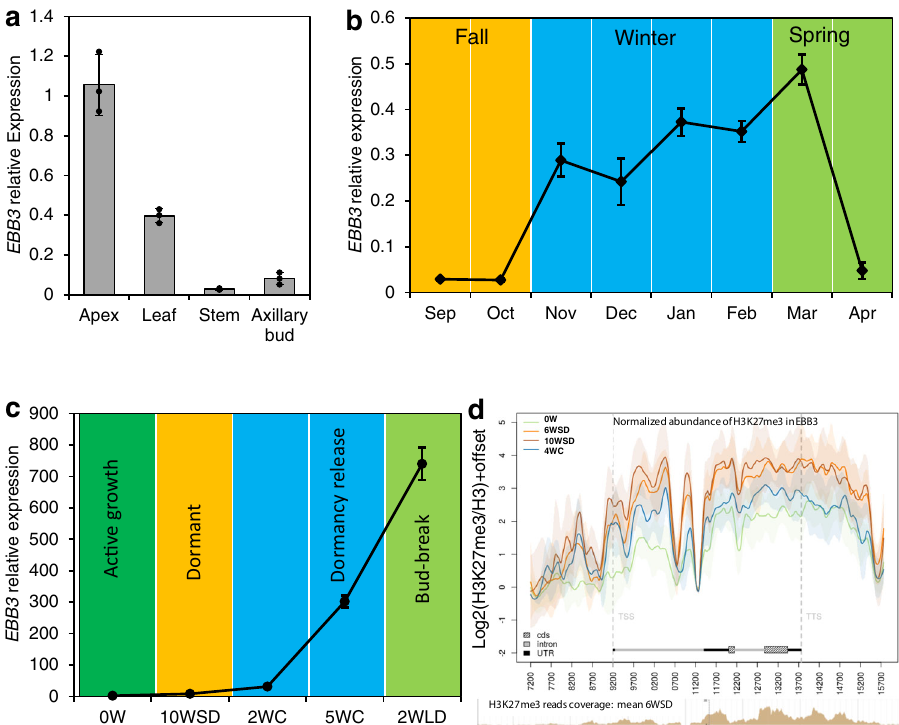
Fig. 3 EBB3 is primarily expressed in the shoot apex and differentially regulated during the dormancy cycle and bud-break. a Relative expression of EBB3 in different tissues of WT-717 plants. b Relative expression of EBB3 in vegetative buds of wild-growing aspen ( Populus tremuloides ) trees. c Relative expression of EBB3 in WT-T89 plants under manipulative dormancy treatments in controlled growth chamber conditions. Expression values are the average of three biological replicates ±SEM, normalized to the reference genes ACT7 for WT-717 clones, and UBQ for WT-T89 clones, respectively. 0 W: time point before inductive treatments, 10 WSD: 10 weeks under SD photoperiod, 2WC: 2 weeks under cold, 5WC: 5 weeks under cold, 2WLD: 2 weeks under LD photoperiod and warm temperature. d Average H3K27me3 abundance of three biological replicates in the EBB3 locus, including 2 Kb downstream and upstream regions, before dormancy inductive treatments (0 W) and during dormancy induction, (6WSD, 10WSD) and dormancy release (4WC). H3K27me3 abundance was normalized relative to H3 abundance. Shaded areas indicate ±standard deviation. TSS transcription start site, TTS